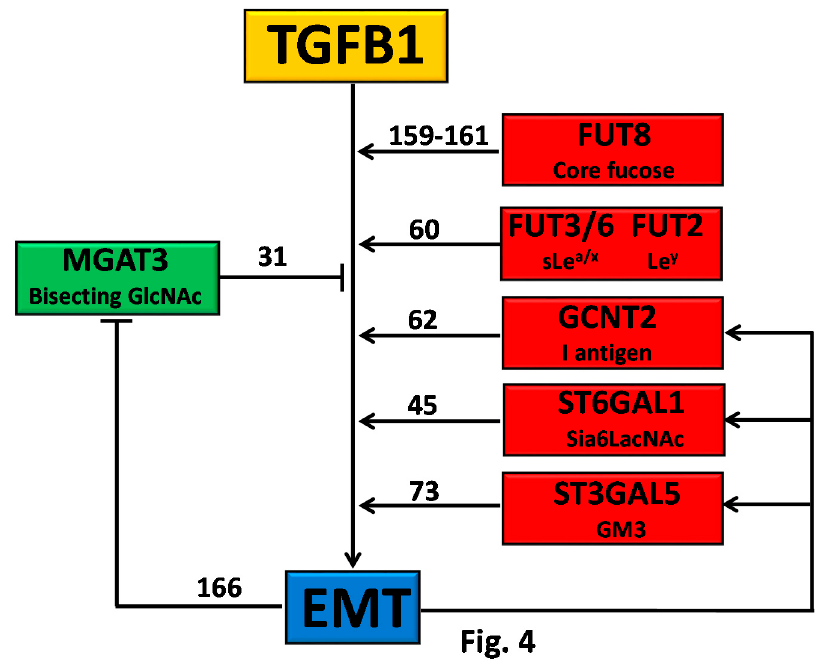
Figure 4. TGFB1 and EMT.Owing to the overexpression of their cognate glycosyltransferases, some carbohydrate structures, indicated on the right, stimulate EMT. In turn, EMT stimulates the glycosyltransferases responsible for the biosynthesis of EMT-promoting structures, originating a self-fueling loop. MGAT3 and its cognate bisecting GlcNAc structure inhibit EMT, however, which inhibits MGAT3 expression, removing a brake to EMT. Numbers indicate the appropriate references.